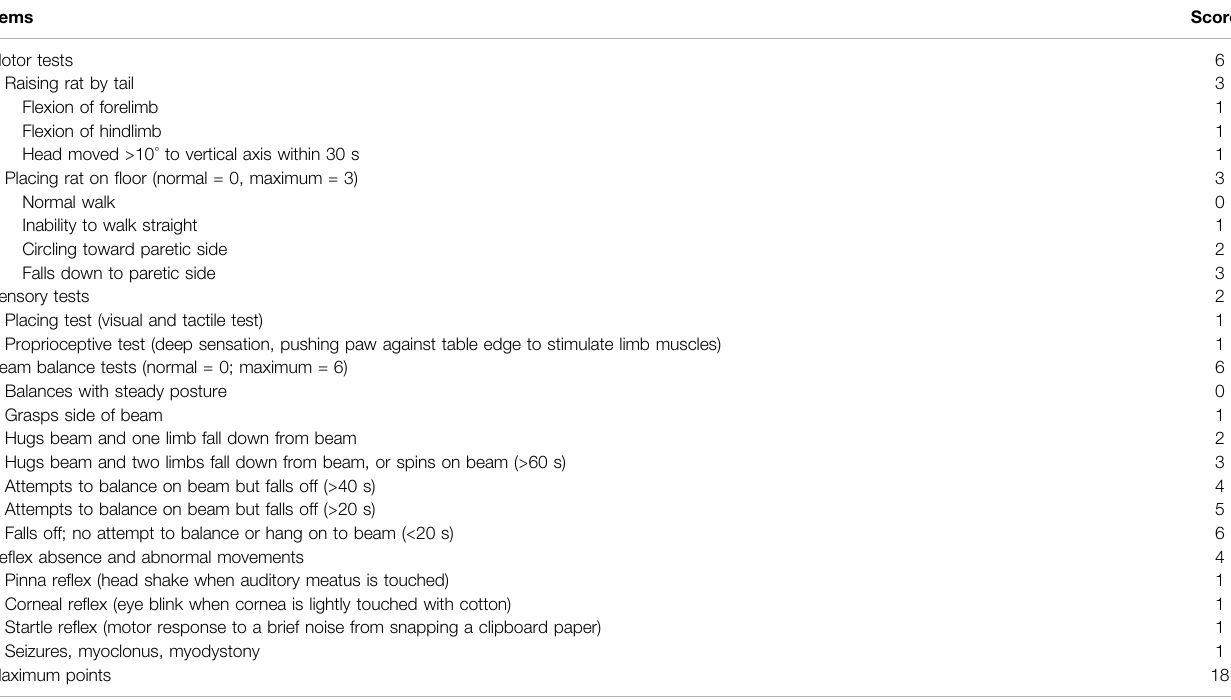
TABLE 1 | Modi fi ed Neurological Severity Score criteria.